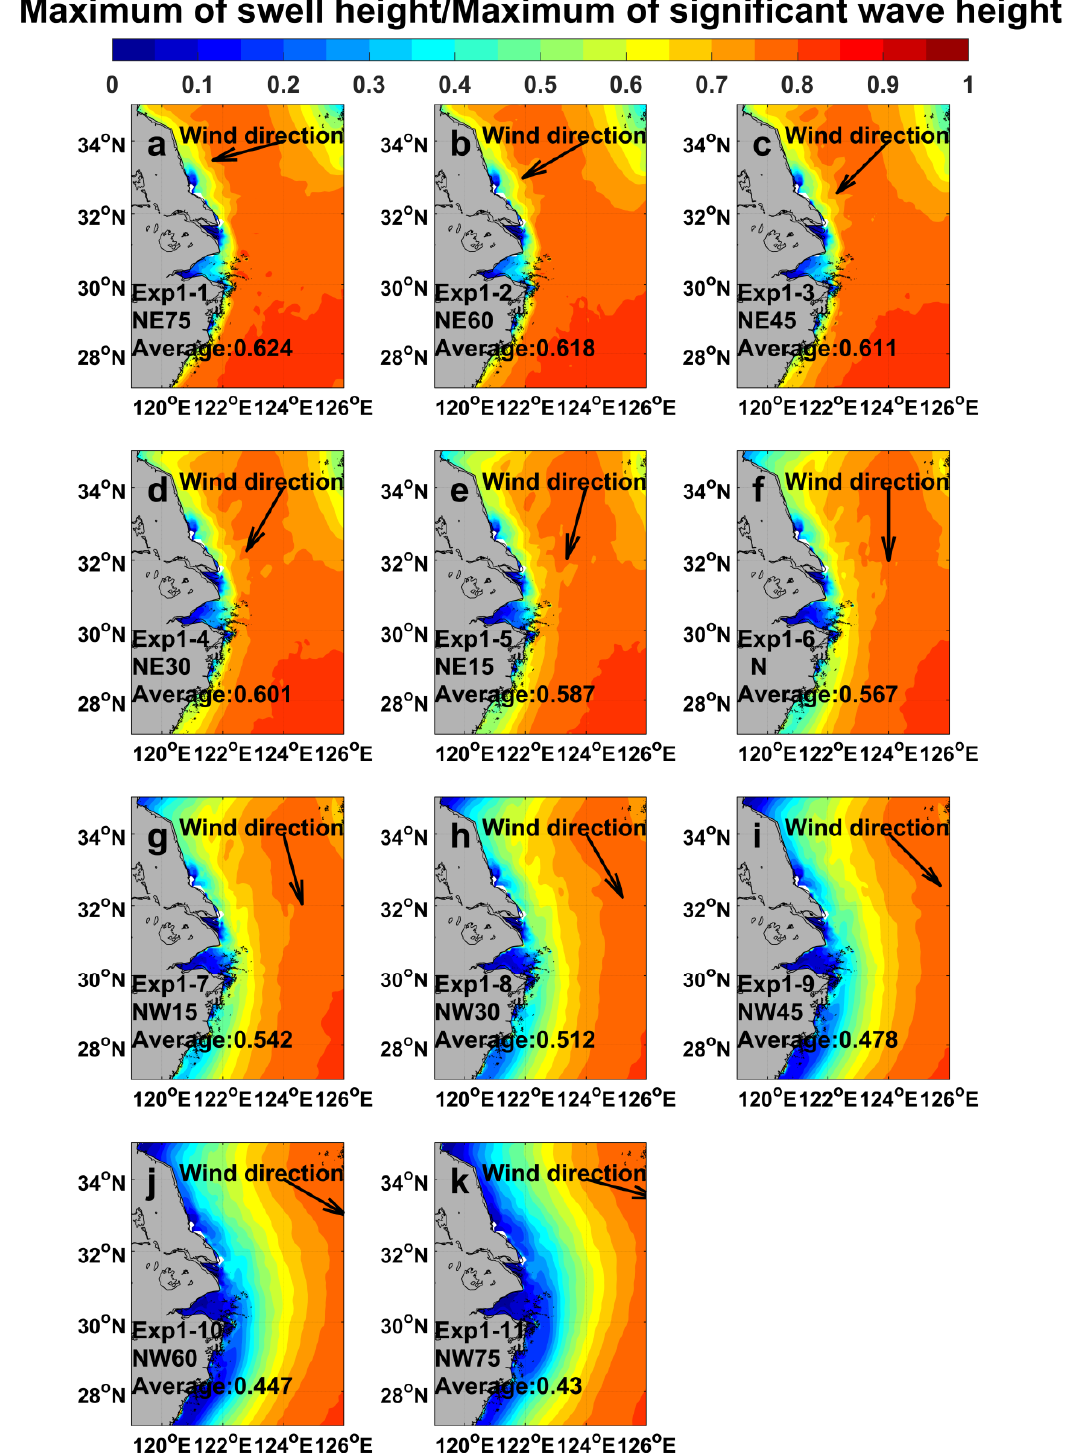
Figure 10. The ratio of the MSH and MSWH (MSH/MSWH) in the study region in ( a ) numerical experiment Exp 1-1, ( b ) numerical experiment Exp 1-2, ( c ) numerical experiment Exp 1-3, ( d ) numerical experiment Exp 1-4, ( e ) numerical experiment Exp 1-5, ( f ) numerical experiment Exp 1-6, ( g ) numerical experiment Exp 1-7, ( h ) numerical experiment Exp 1-8, ( i ) numerical experiment Exp 1-9, ( j ) numerical experiment Exp 1-10, ( k ) numerical experiment Exp 1-11. The nearshore waves are dominated by wind waves, while the offshore waves are dominated by swells. The mean ratio of the MSH and MSWH decreases as the wind direction changes from 75 ◦ N.E to 75 ◦